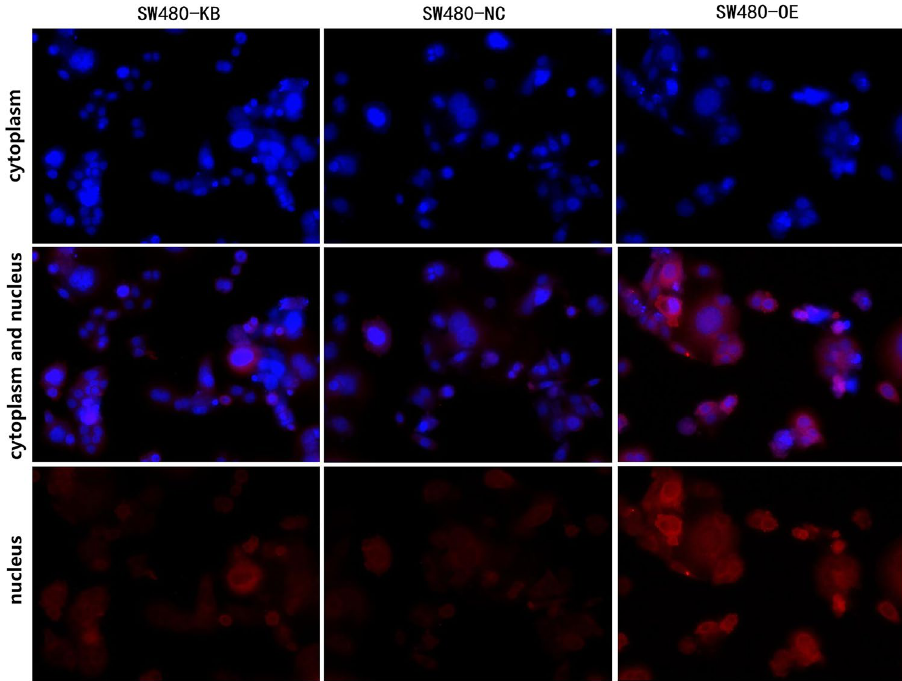
(Fig. 3B, C). ORF3a significantly inhibited the migration ability of CRC cells (Fig. 3D, E). Further research into the effect of ORF3a on the cell cycle of CRC found that ORF3a blocked SW480 CRC cells in the G1 phase (Fig. 3F, G).